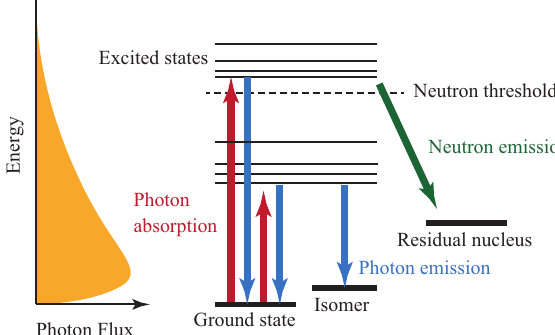
Figure 6. Schematic view of the interaction between an atomic nucleus and a photon. The nucleus is excited by the absorption of a photon. The excited state can decay to the ground state or the isomer by the emission of a photon (photons). If the excitation energy is higher than the neutron threshold, the state can decay to the residual nucleus by the emission of a